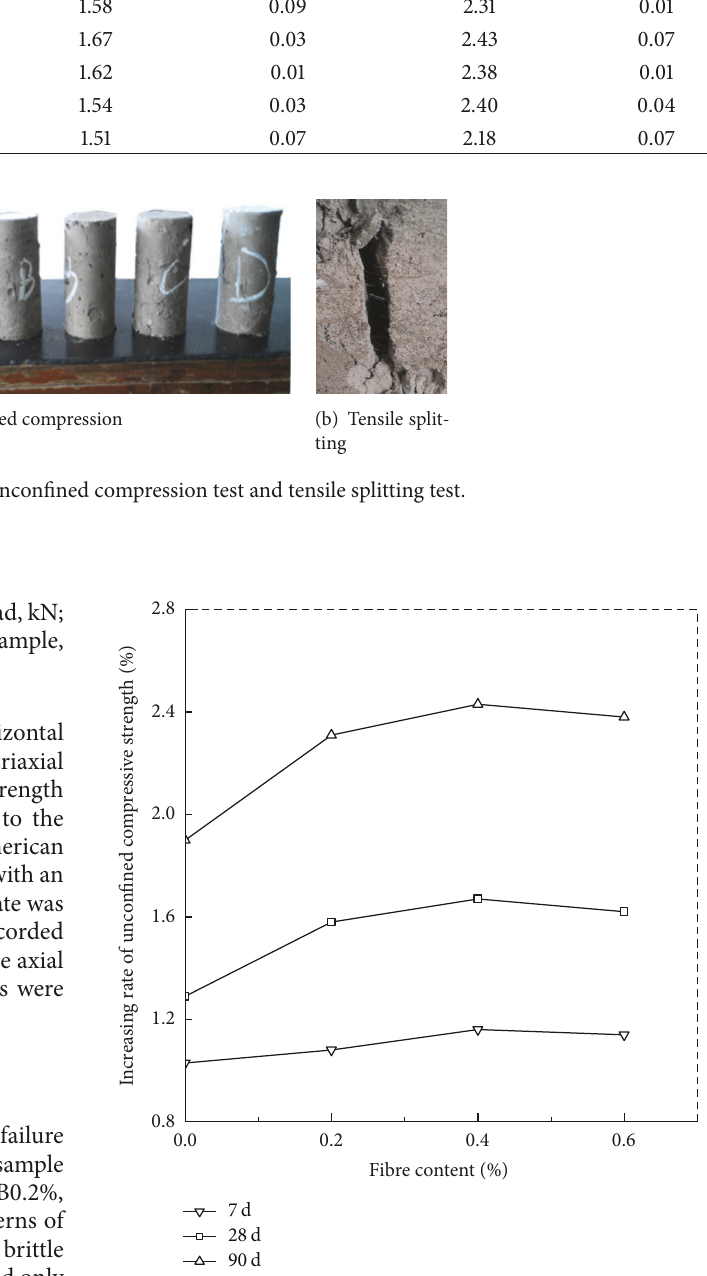
Figure 4: The relations of fibre content and